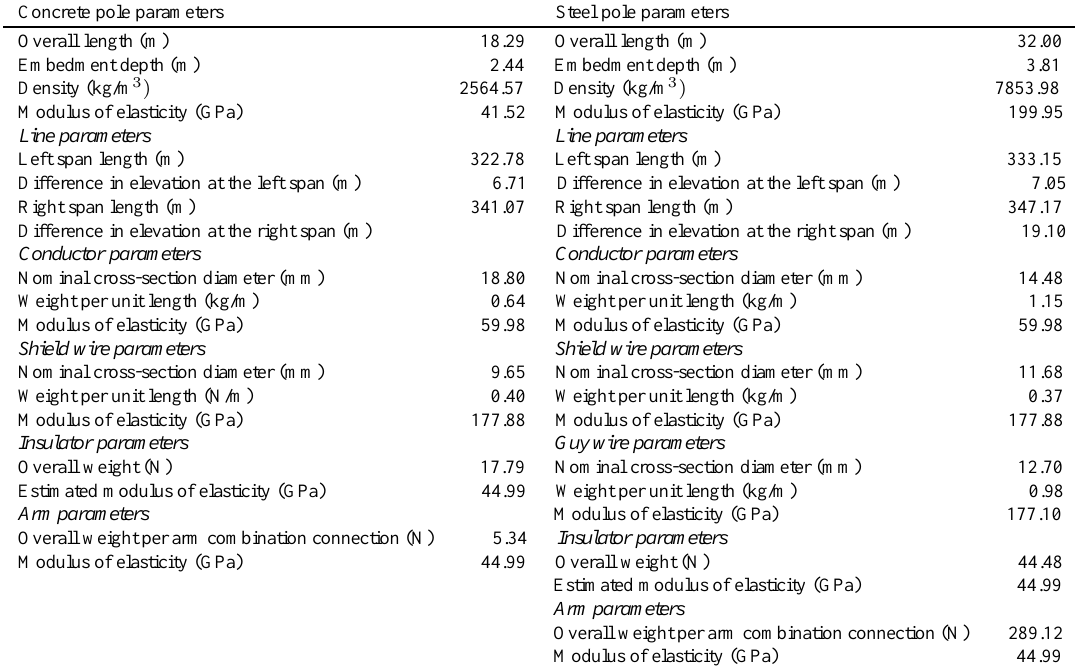
Table 3 Parameters of the concrete and steel pole-line